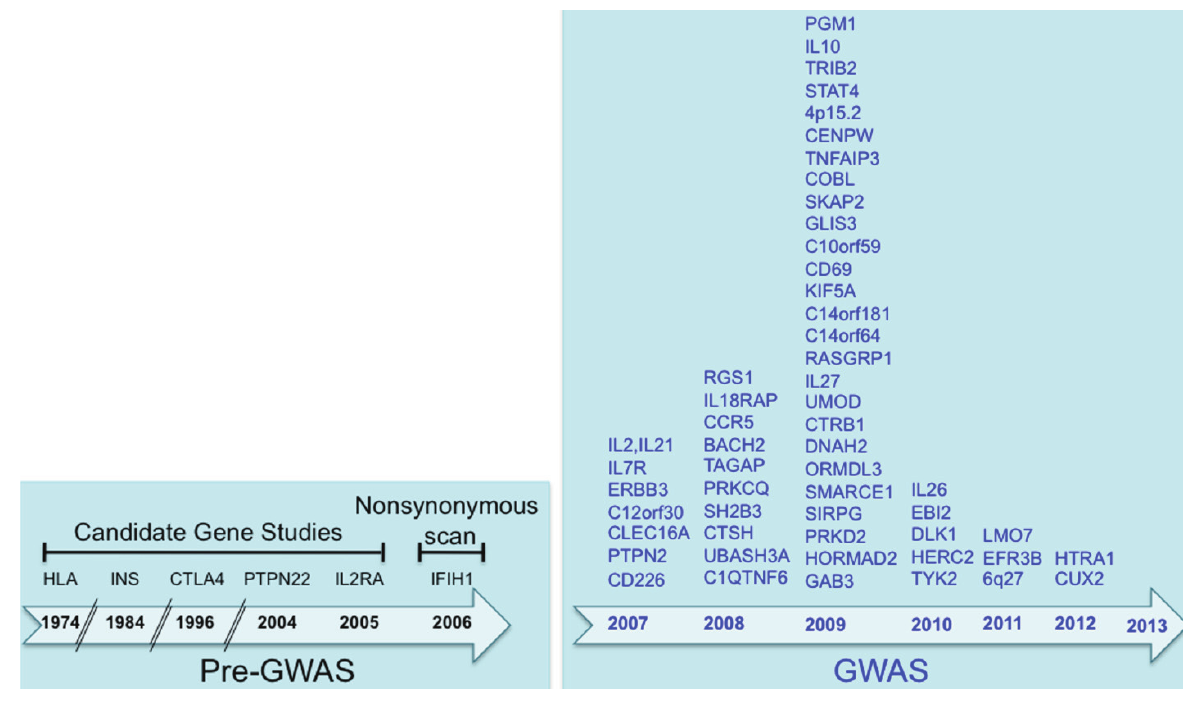
Figure 1. The Type 1 Diabetes loci described to date: a timeline. The susceptibility loci are presented by the year they were first implicated in